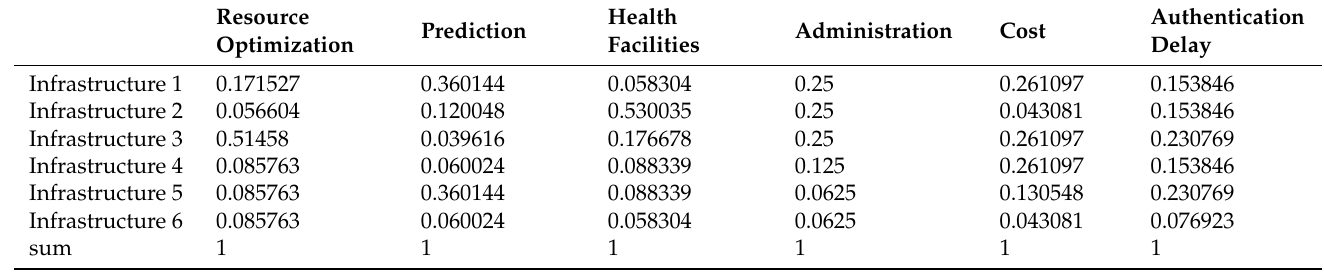
Table 4. Normalized Matrix.